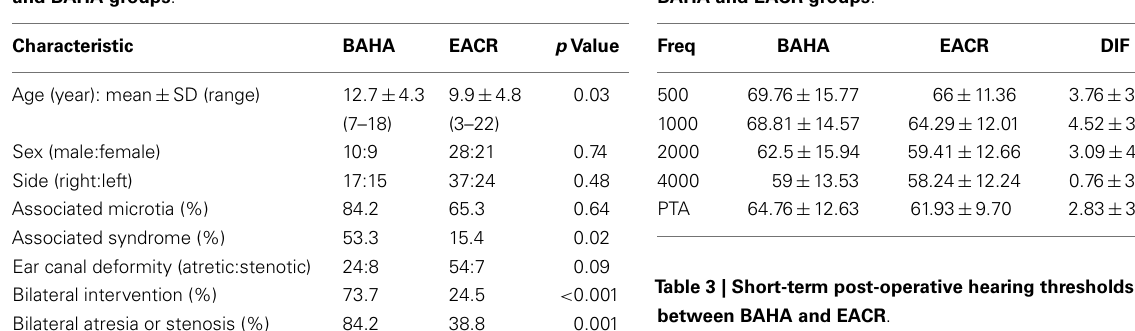
Table 2 | Pre-operative hearing thresholds comparison between the